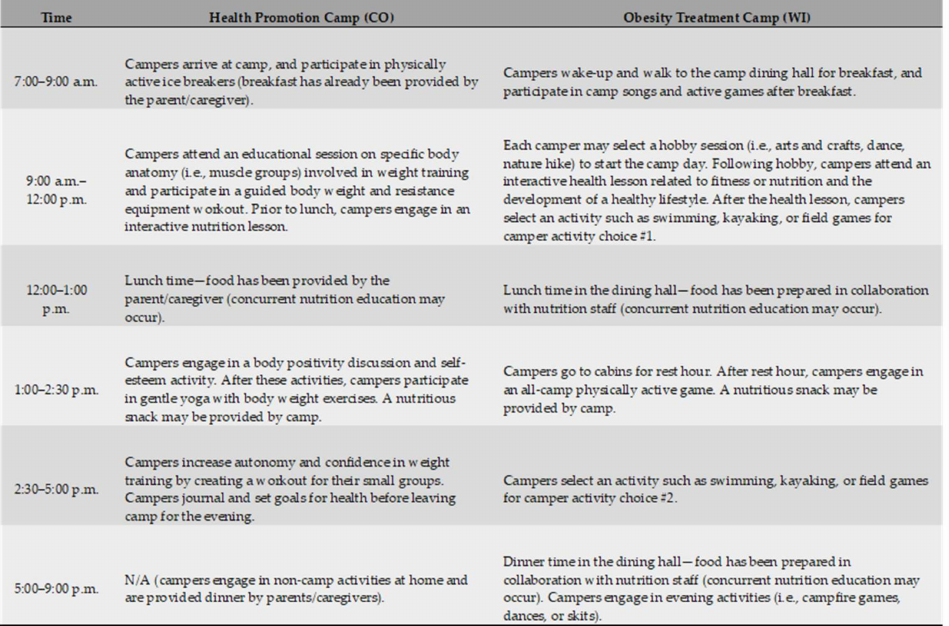
Figure 1. Overview of camp programming provided at the health promotion cohort (Colorado, CO) and the obesity treatment cohort (Wisconsin, WI). Total time spent in physical activity: 2–3 h (CO); 2–4 h (WI). N/A: not